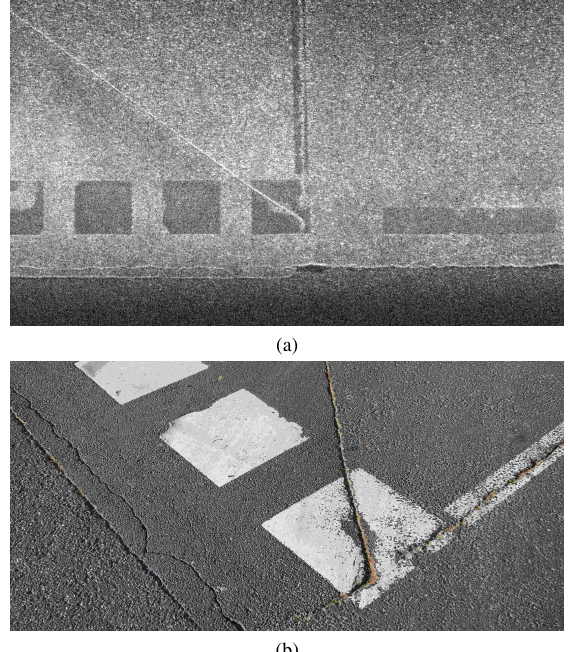
Figure 6: Zoom ( 4 m x 4 m) of street intersection. (a) SAR image zoom of the center of Fig. 4a. Cracks in the asphalt of 2 cm down to several millimeters are recognisable. Best detection of cracks, however, if these are parallel to the movement of the sensor. (b) Photograph of the scene.